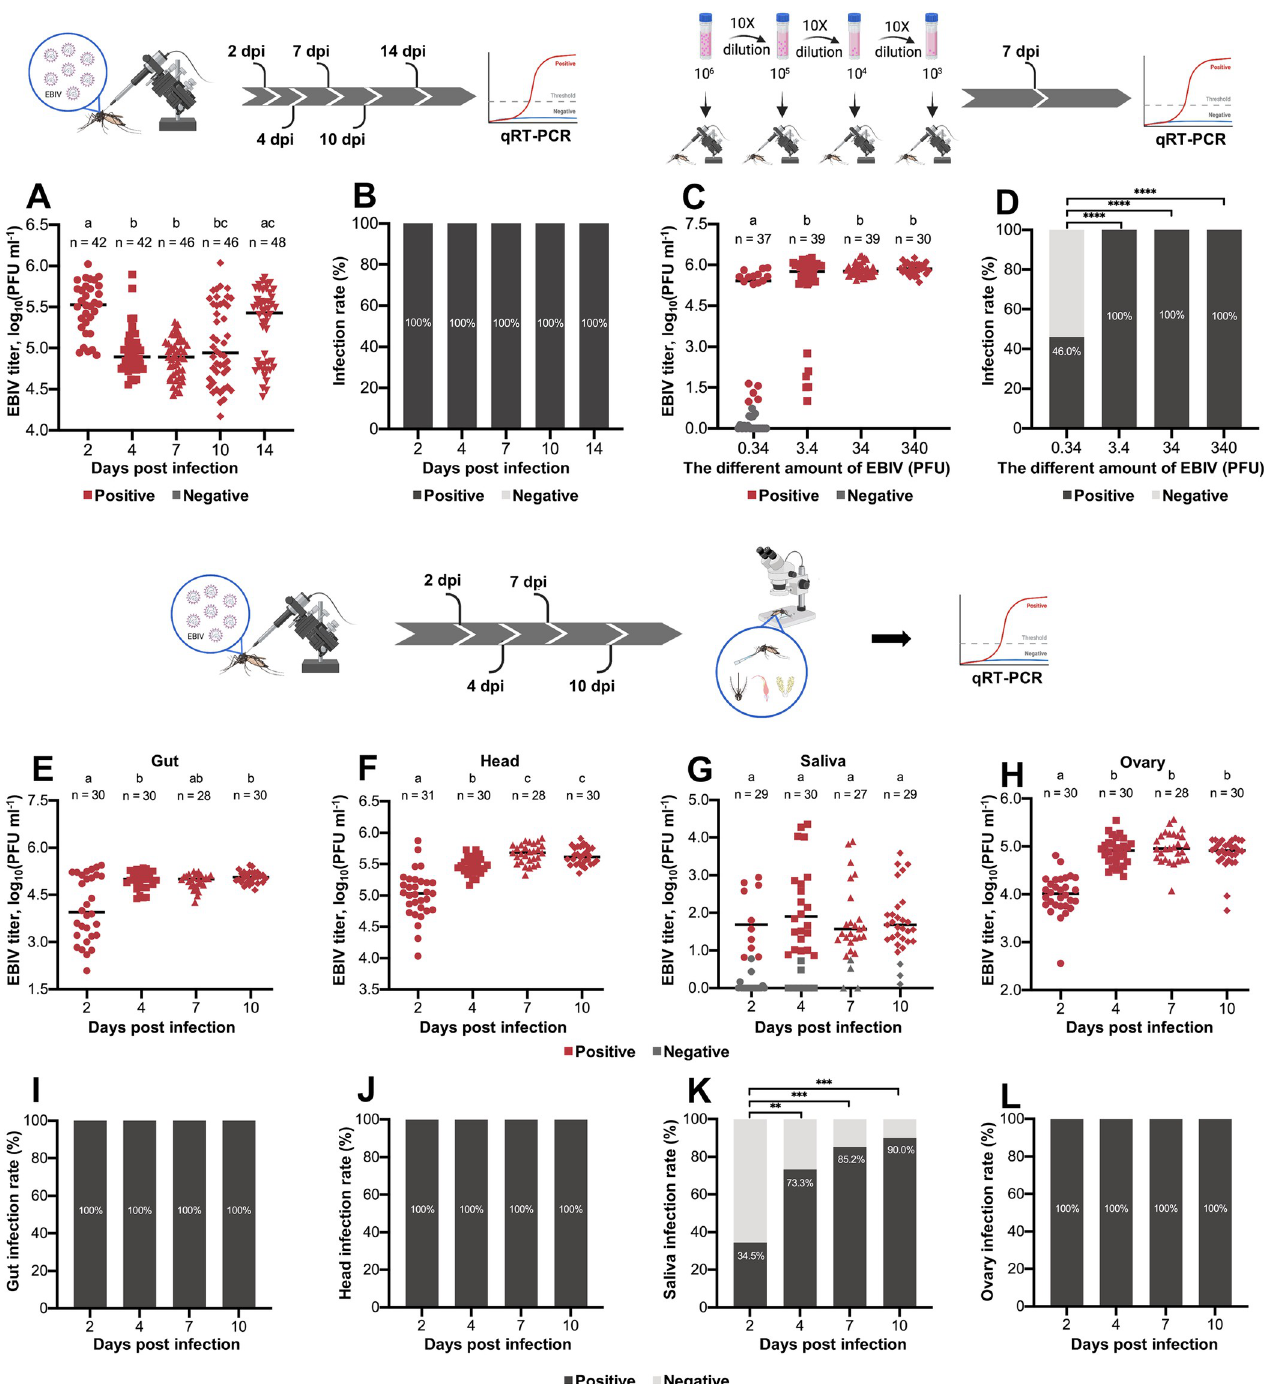
Fig 2. EBIV titers and infection rates of Ae . aegypti through intrathoracic inoculation. EBIV titers (A) and infection rates (B) of mosquitoes at 4, 7, 10 and 14 days after injection with 340 PFU EBIV. EBIV titers (C) and infection rates (D) of mosquitoes injected with 0.34 to 340 PFU EBIV at 7 dpi. EBIV titers in gut (E), head (F), saliva (G) and ovary (H) samples of mosquitoes injected with 34 PFU EBIV at 2, 4, 7 and 10 dpi. Gut (I), head (J), saliva (K) and ovary (L) infection rates of mosquitoes injected with 34 PFU EBIV at 2, 4, 7 and 10 dpi. Each dot represents an individual mosquito. The same letters indicate no significant differences (multiple comparisons using non-parametric Kruskal-Wallis analysis). Differences in rates were analyzed with Fisher’s exact test ( � : p � 0.05, �� : p � 0.01, ��� : p � 0.005 and ���� : p � 0.001).